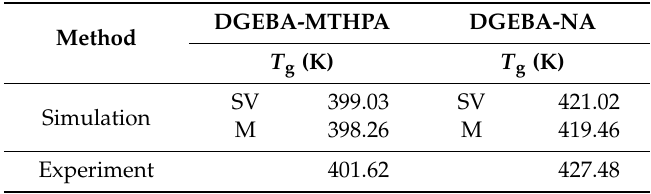
Table 4. Simulation and experimental results of the T g calculated by the specific volume-temperature method (SV) and the MSD-temperature method (M).